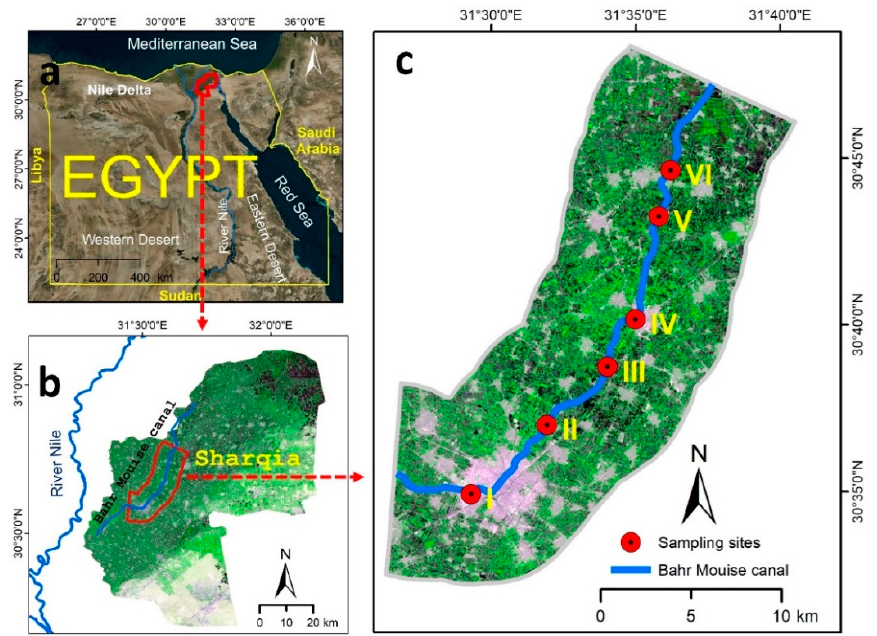
Figure 1. Location of the Bahr Mouise canal in the El-Sharkia Governorate, Egypt (( a ) and ( b )), as well as the six sampling sites ( c ).